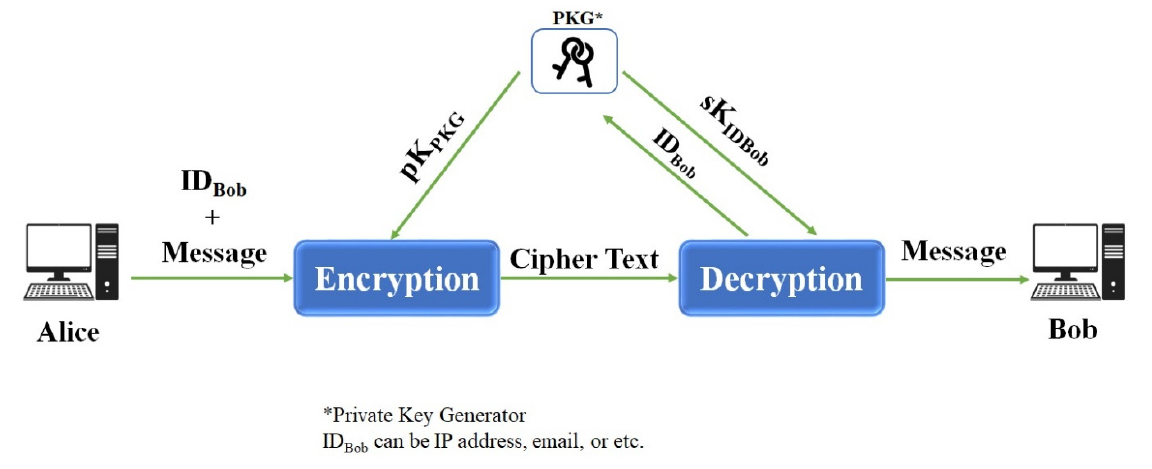
Figure 9. Identity-based encryption.